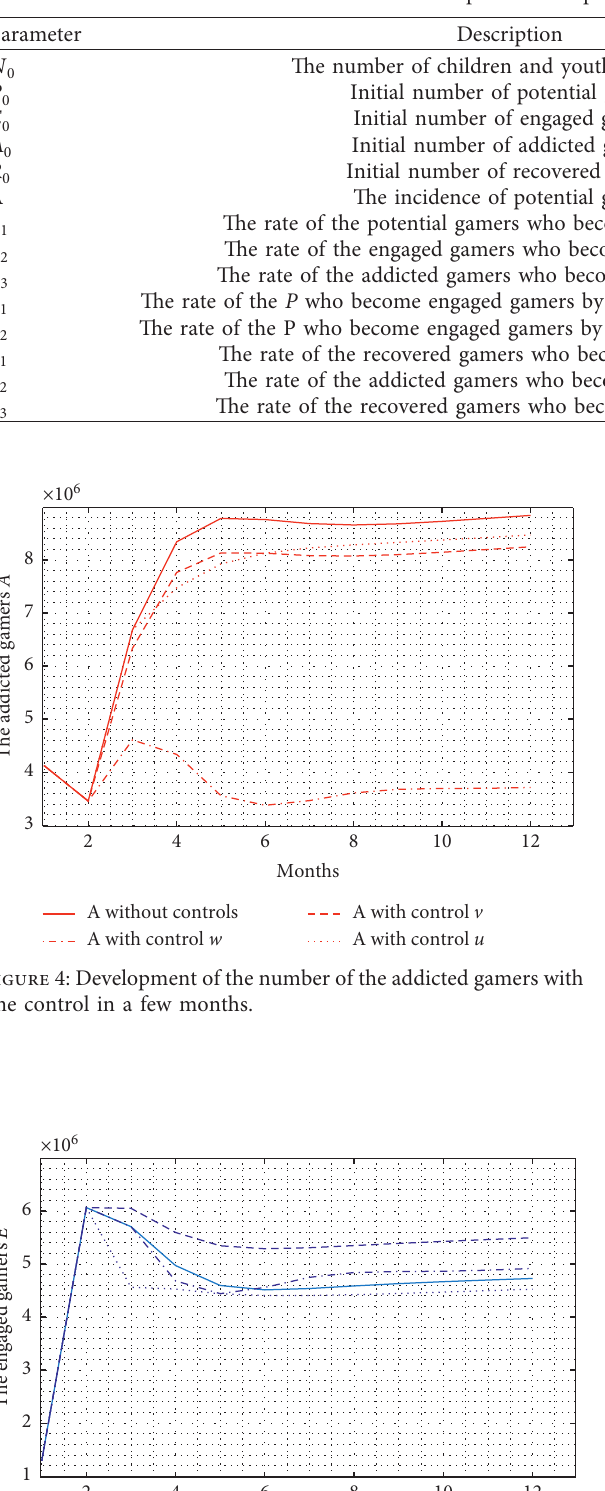
Table 1: The description of the parameters data used for systems (1).